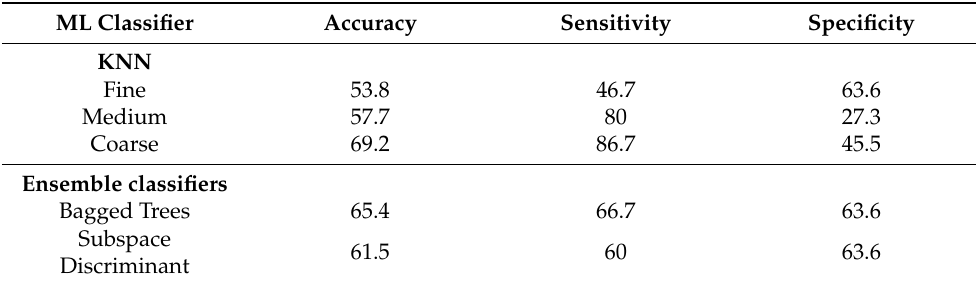
Table 2. Accuracy, sensitivity, and specificity (expressed as percentage) of the ML classifiers investi- gated. The best performances are highlighted in